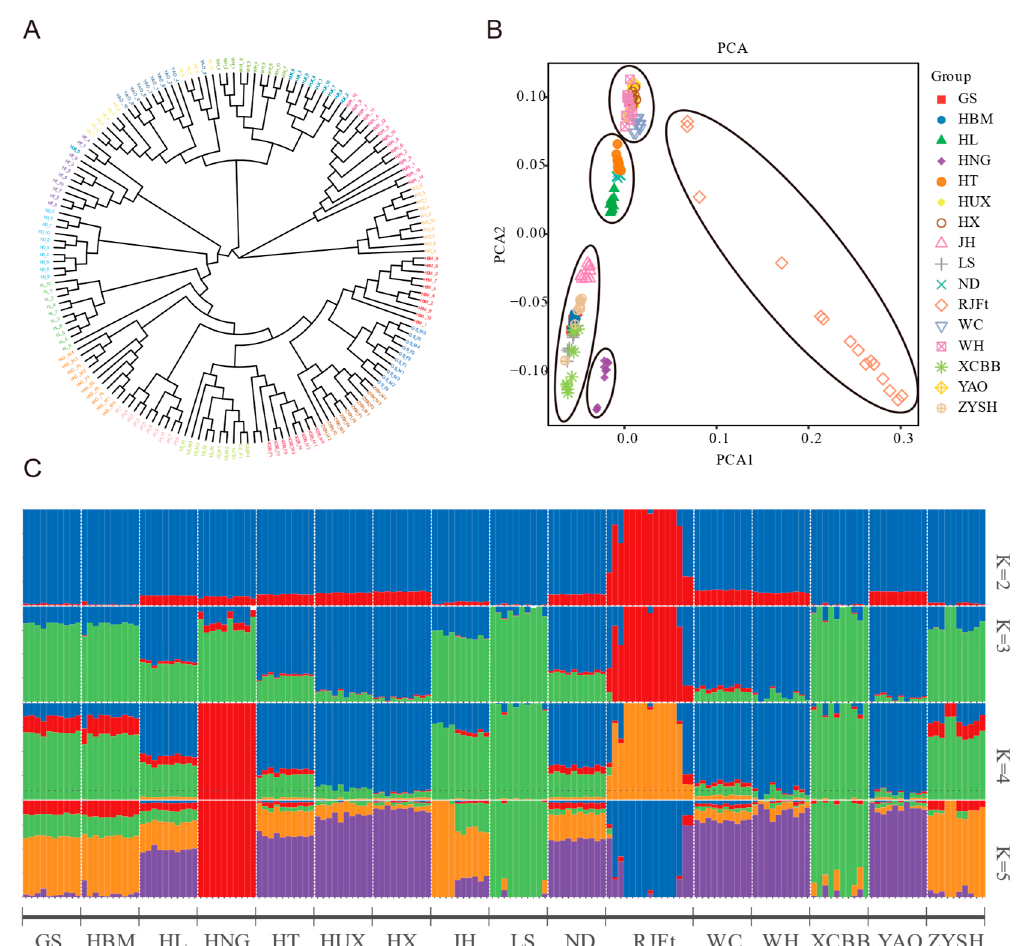
Figure 1. Genetic relationships and population structure between Henan indigenous chickens and other Chinese chicken breeds. ( A ) Neighbor-joining (NJ) phylogenetic tree of 16 breeds. ( B ) Principal component analysis (PCA) of 16 chicken populations. ( C ) Admixture analysis across 16 chicken populations. Proportions of genetic ancestry for 16 chicken populations with K = 2–5 (K represents the number of inferred ancestral populations. Different colors represent assumed